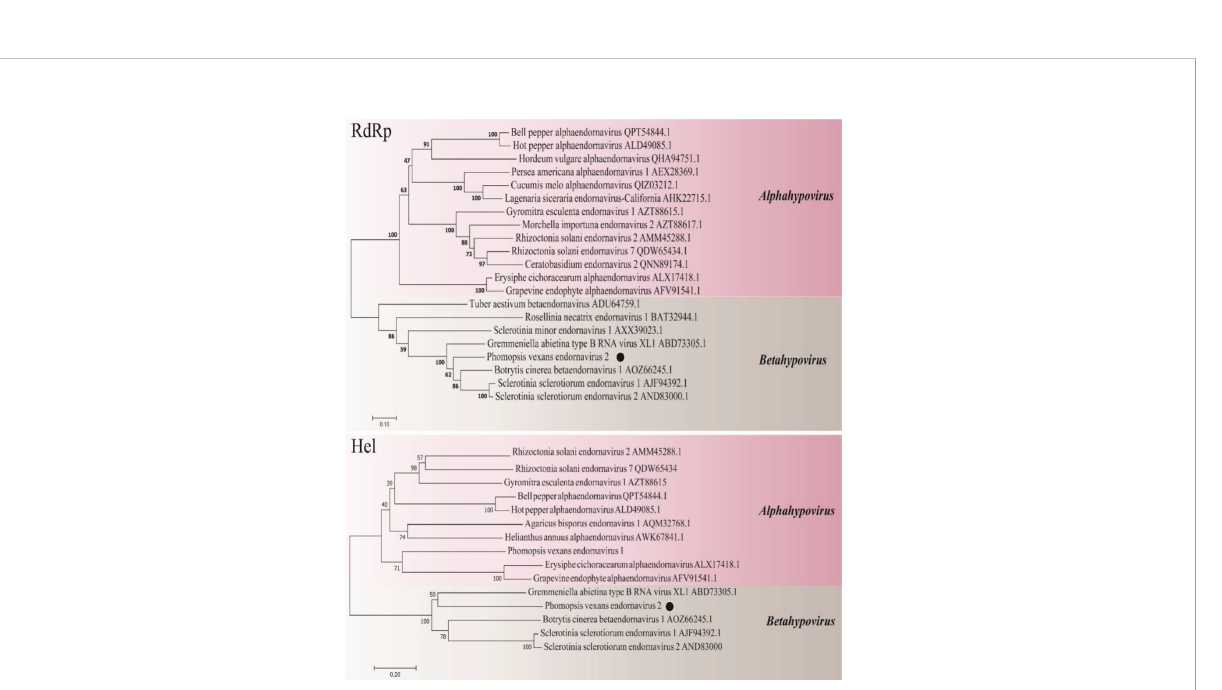
FIGURE 11 Phylogenetic analysis of PvEV2. Phylogenetic analysis illustrating the evolutionary classi fi cation of PvEV2 was conducted using the method described in Figure 7. The genetic distance is represented by the scale bar of 0.2 aa substitutions per site. The novel virus PvEV2 is indicated by black dots. The names and database accession numbers of other related viruses analyzed are indicated in the tree.